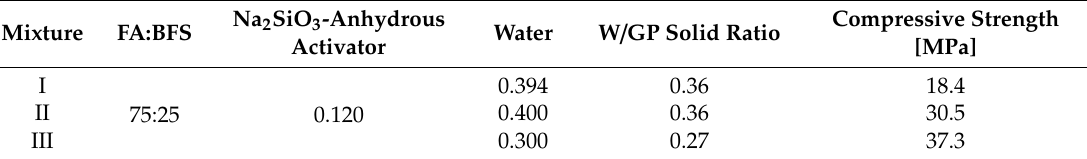
Table 5. Compressive strength of non-heat-treated FA–BFS Geopolymers [25]. Na 2 SiO 3 -Anhydrous Mixture FA:BFS Activator